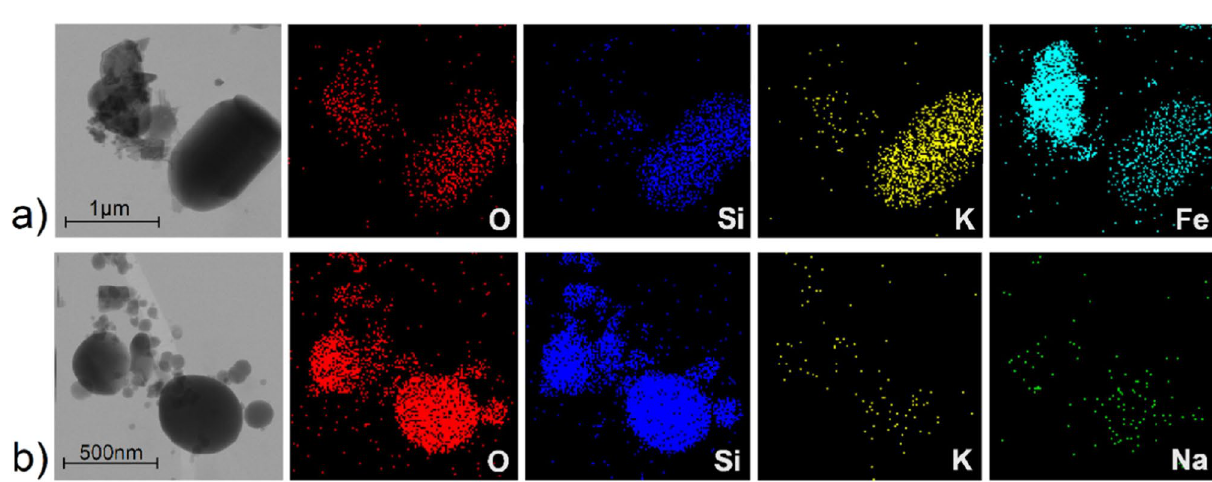
Figure 6. STEM and EDX images of isolated materials from ( a ) blood clot after 1 h and ( b ) liver after 8 h of